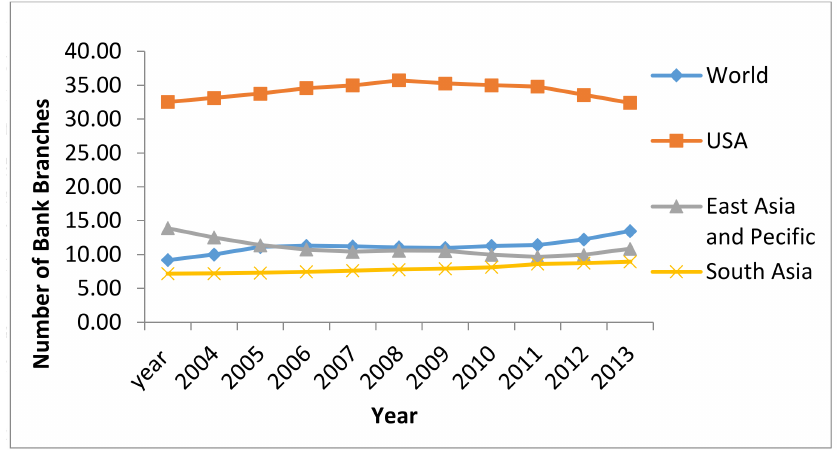
Figure 2. Commercial bank branches per 100,000 adults (Source: World Development Indicators- World